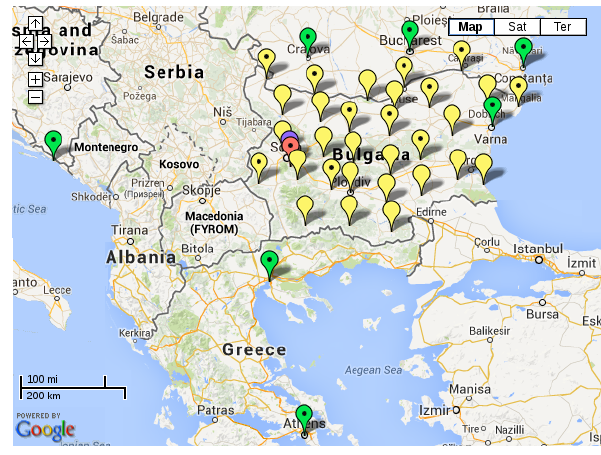
Figure 2. SUADA GNSS stations in Bulgaria/southeastern